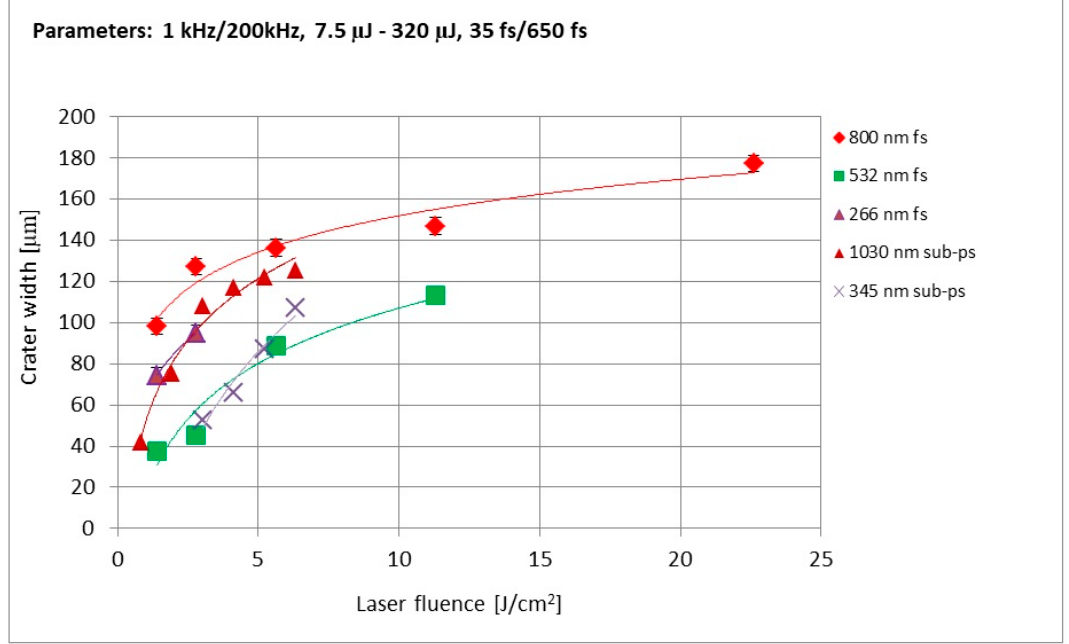
Figure 6. Ablation dependence on laser fluence for different wavelengths.